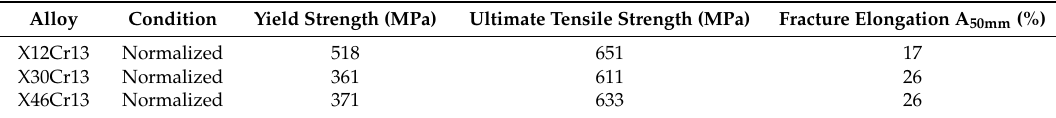
Table 2. Mechanical properties of the investigated alloys in the as-supplied condition at room temperature in the rolling direction.